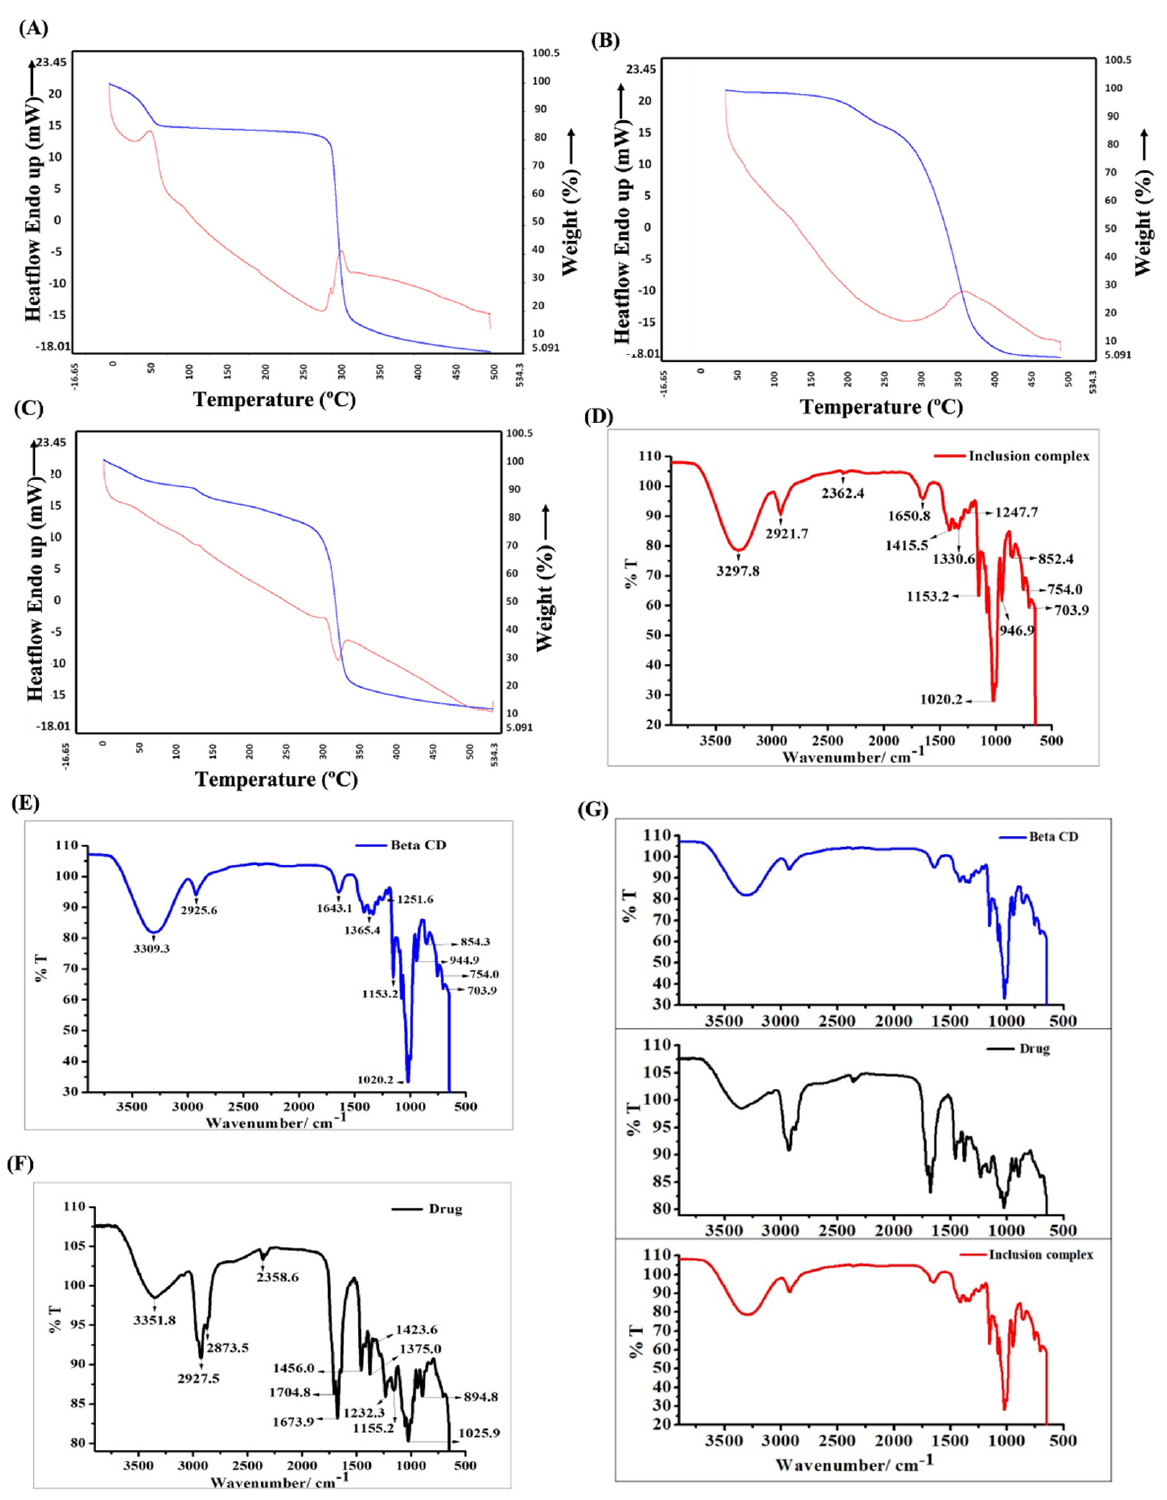
Figure 2. TGA (Blue)/DSC (Red) analysis of ( A ) BCD, ( B ) AC, and ( C ) IC. FT-IR spectral analysis of ( D ) IC, ( E ) BCD, and ( F ) AC. ( G ) Merged FT-IR spectra of BCD, AC (drug), and IC.